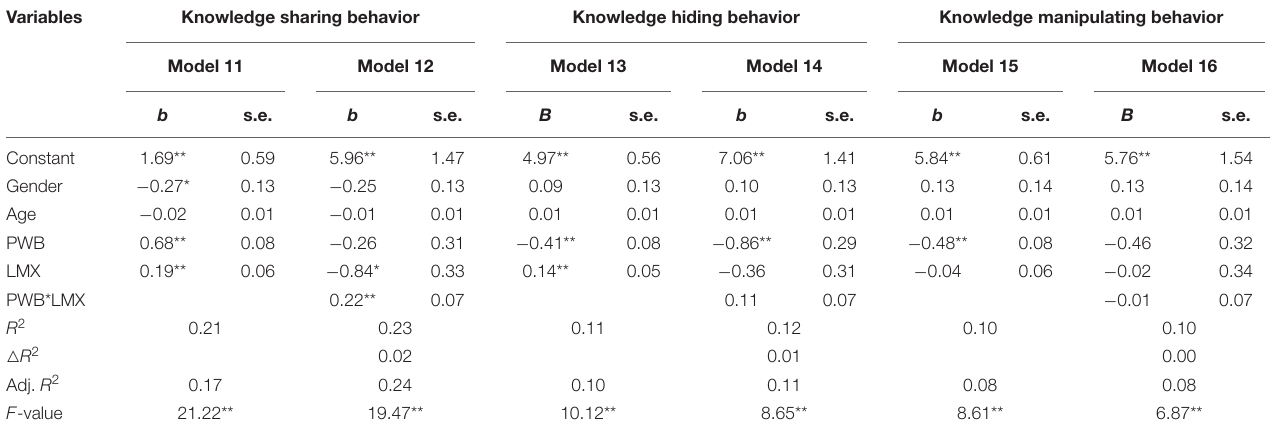
TABLE 5 | Results of moderating analysis for hypothesis 8.